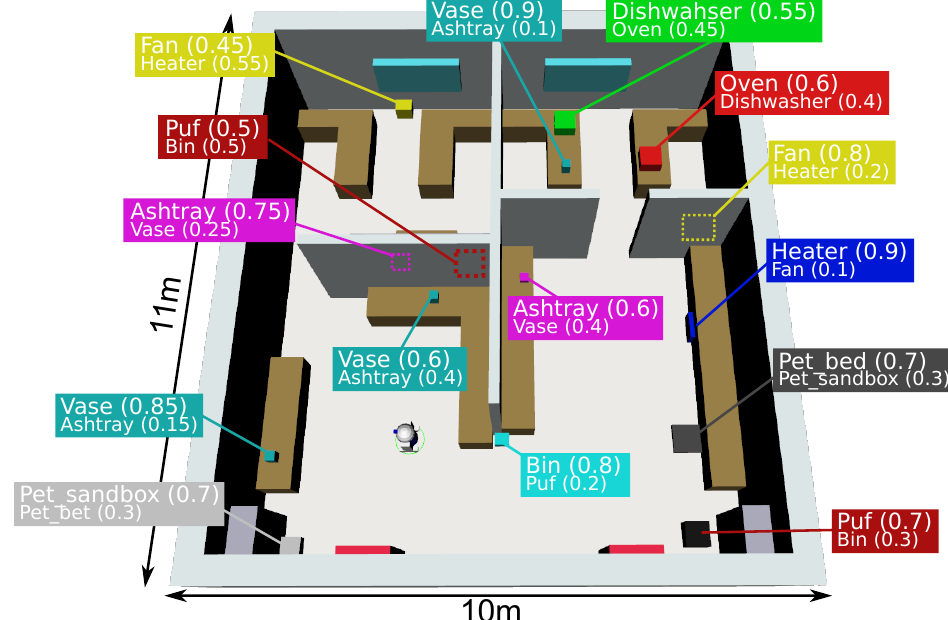
Figure 3. 3D simulated home environment composed of four interconnected rooms and fifteen object candidates. Objects are shown as 3D colored boxes specifying their location in the environment and their categorization